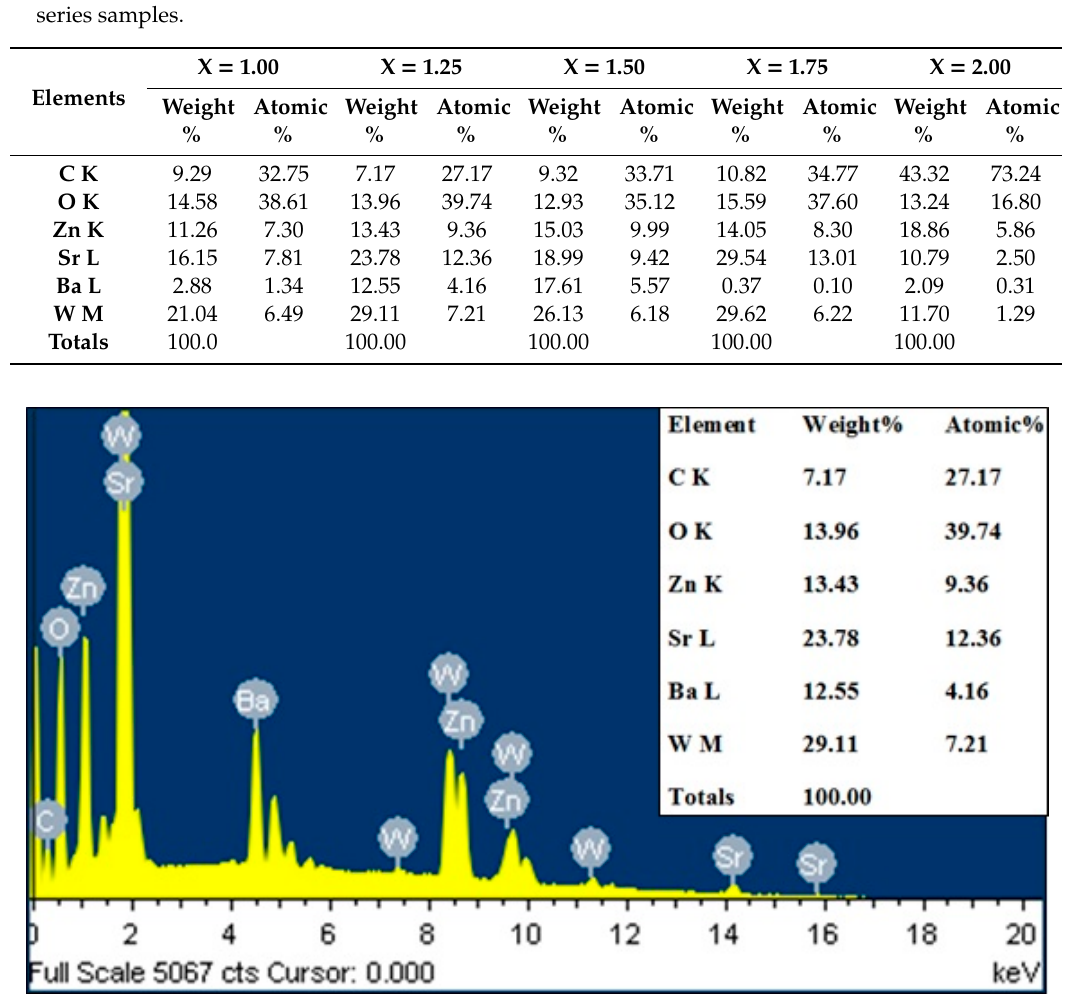
Figure 5. EDX result of the Ba 1.75 Sr 0.25 ZnWO 6 sample.